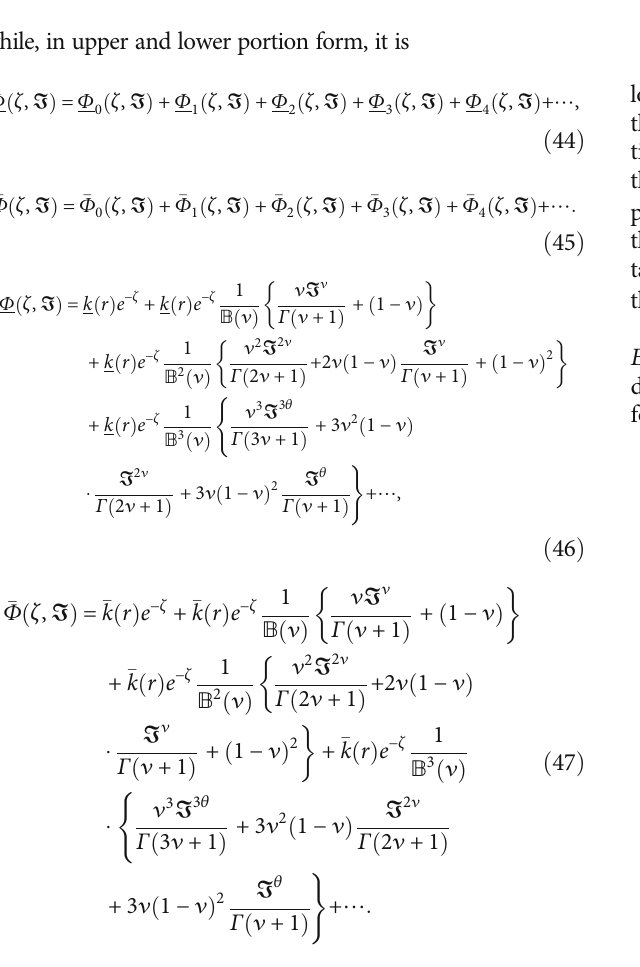
The exact solution of equation (33) is given as